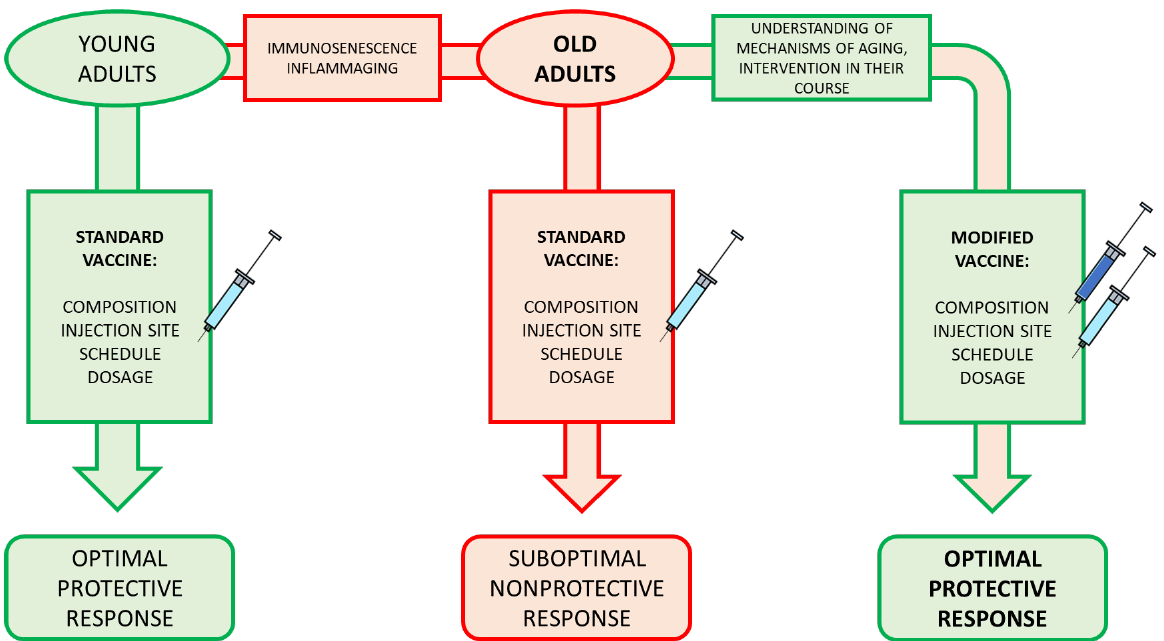
Figure 2. When we age from young adults to old adults, we experience immunosenescence and inflammaging, which impact our response to vaccinations, making it suboptimal (red track). However, if studies on the mechanisms of ageing (esp. immune system ageing) give us the targets (described in the text), we may intervene, on one hand, in the processes of inflammaging and immunosenescence, and, on the other, by modifying the vaccine to better suit old subjects (green